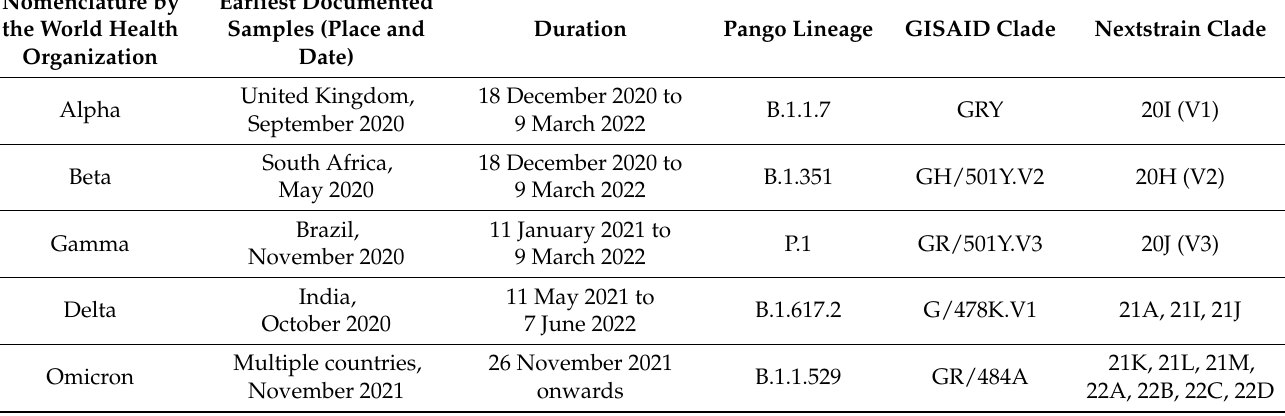
Table 2. Chronology of SARS-CoV-2 variants of concern during the COVID-19 pandemic a